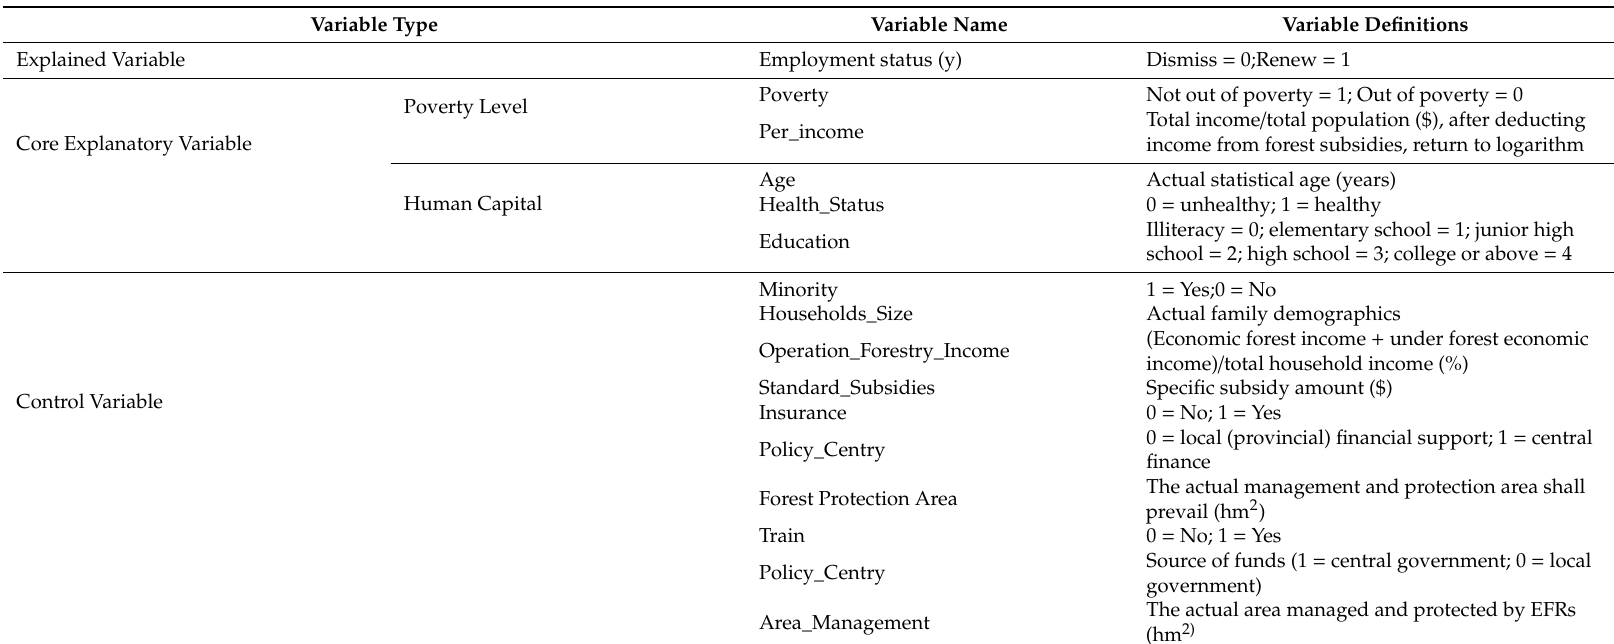
Table 4. Variable